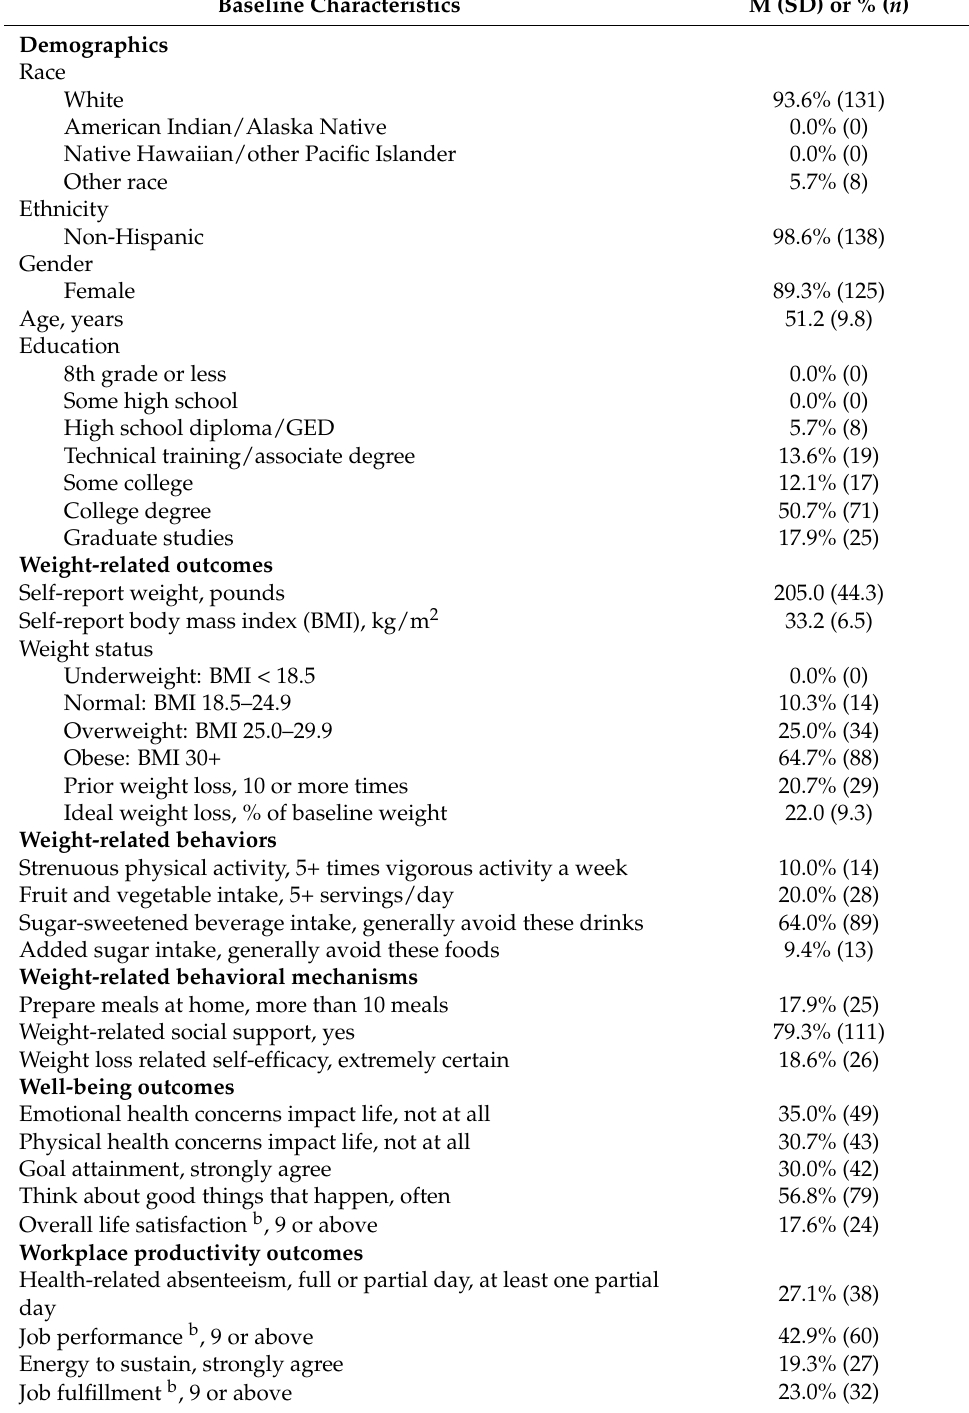
Table 1. Baseline characteristics of participants, n = 140 a